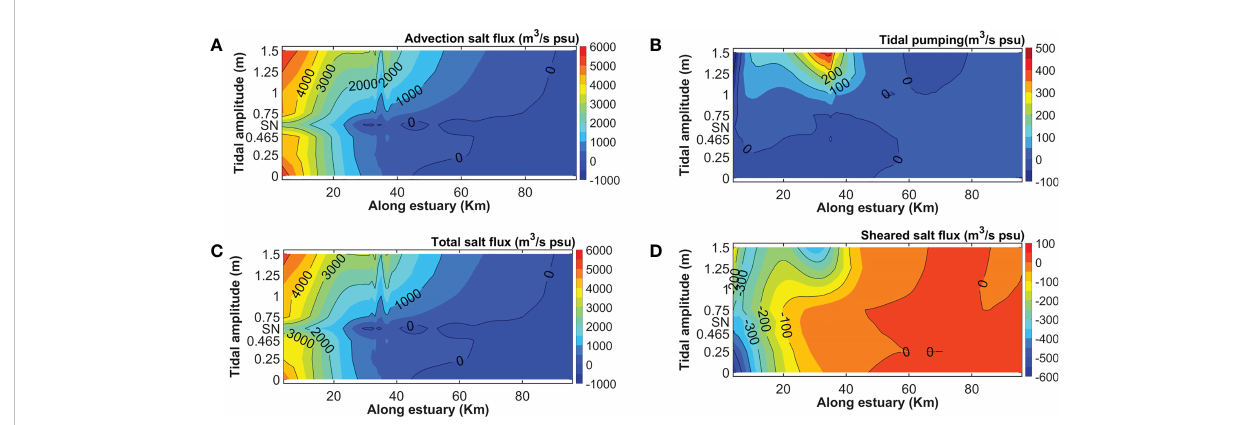
FIGURE 12 The time averaged advective (A) , tidal pumping (B) , total (C) and sheared (D) salt fl uxes along the estuary from 8 scenarios of EXP4-EXP11 (see Table 1), as a function of distance from the estuary mouth (x-axis) and tidal amplitudes at the estuary mouth (y-axis). “ SN ” on the y-axis stands for the spring-neap scenario of EXP11 and positive fl uxes are landward.